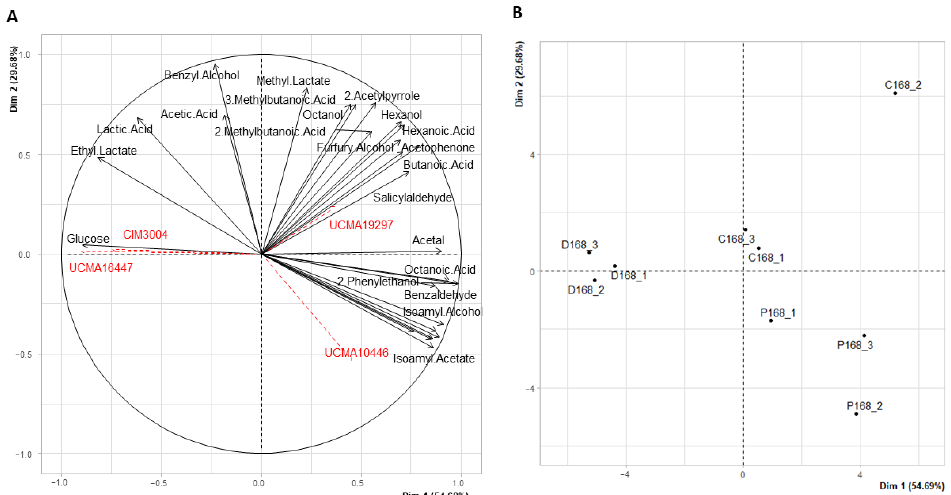
Figure 3. ( A ) Principal Component Analysis of the studied compounds (black arrows) with illustra- tive variables representing the four strains of the model microbial community (red arrows). ( B ) Dis- tribution of the samples in condition C (control), D (disturbance without phages) and P (disturbance